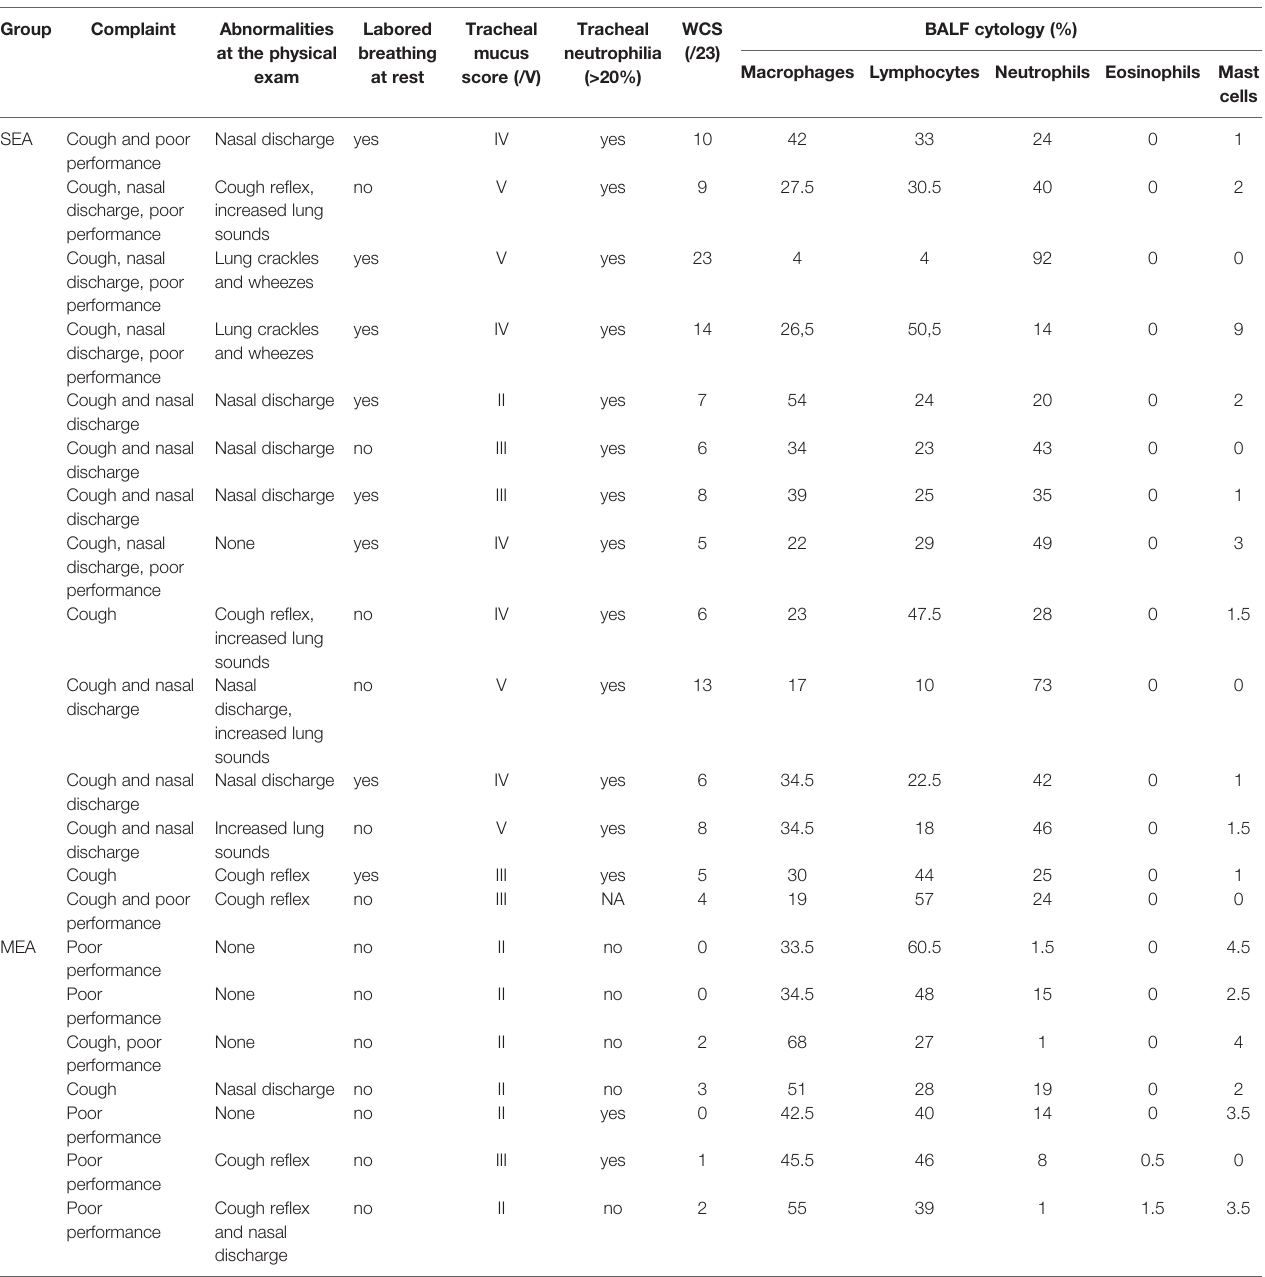
TABLE 2 | Clinical characteristics, airway mucus and cytology fi ndings of asthmatic horses enrolled in this study.